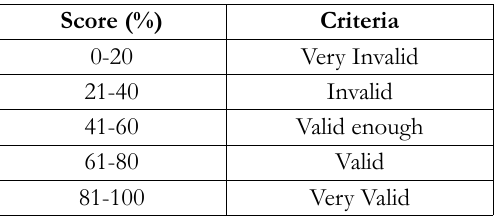
Table 1. Criteria for interpretation of